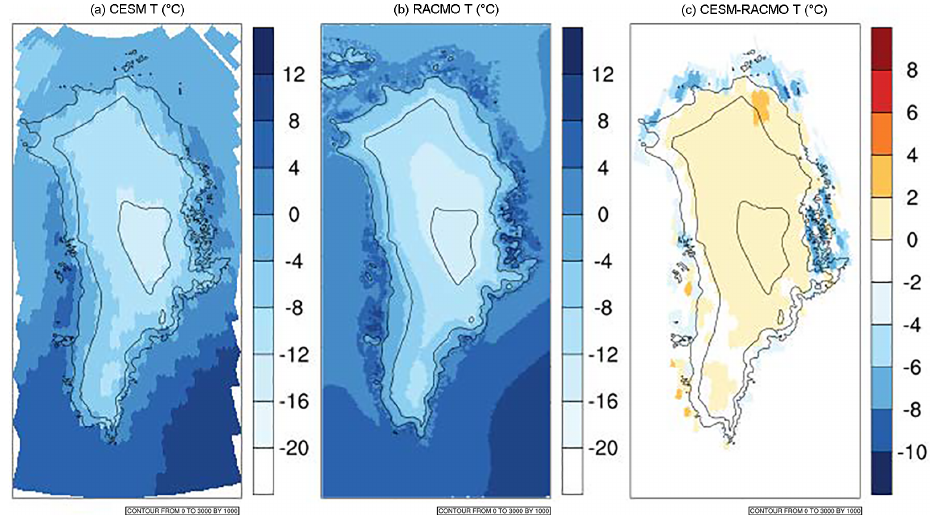
Figure 6. Averages for the JJA season of surface temperature over the GrIS for CESM (a) , RACMO2.3 (b) , and CESM-RACMO2.3 (c) . Elevation contours are as in Fig. 5.